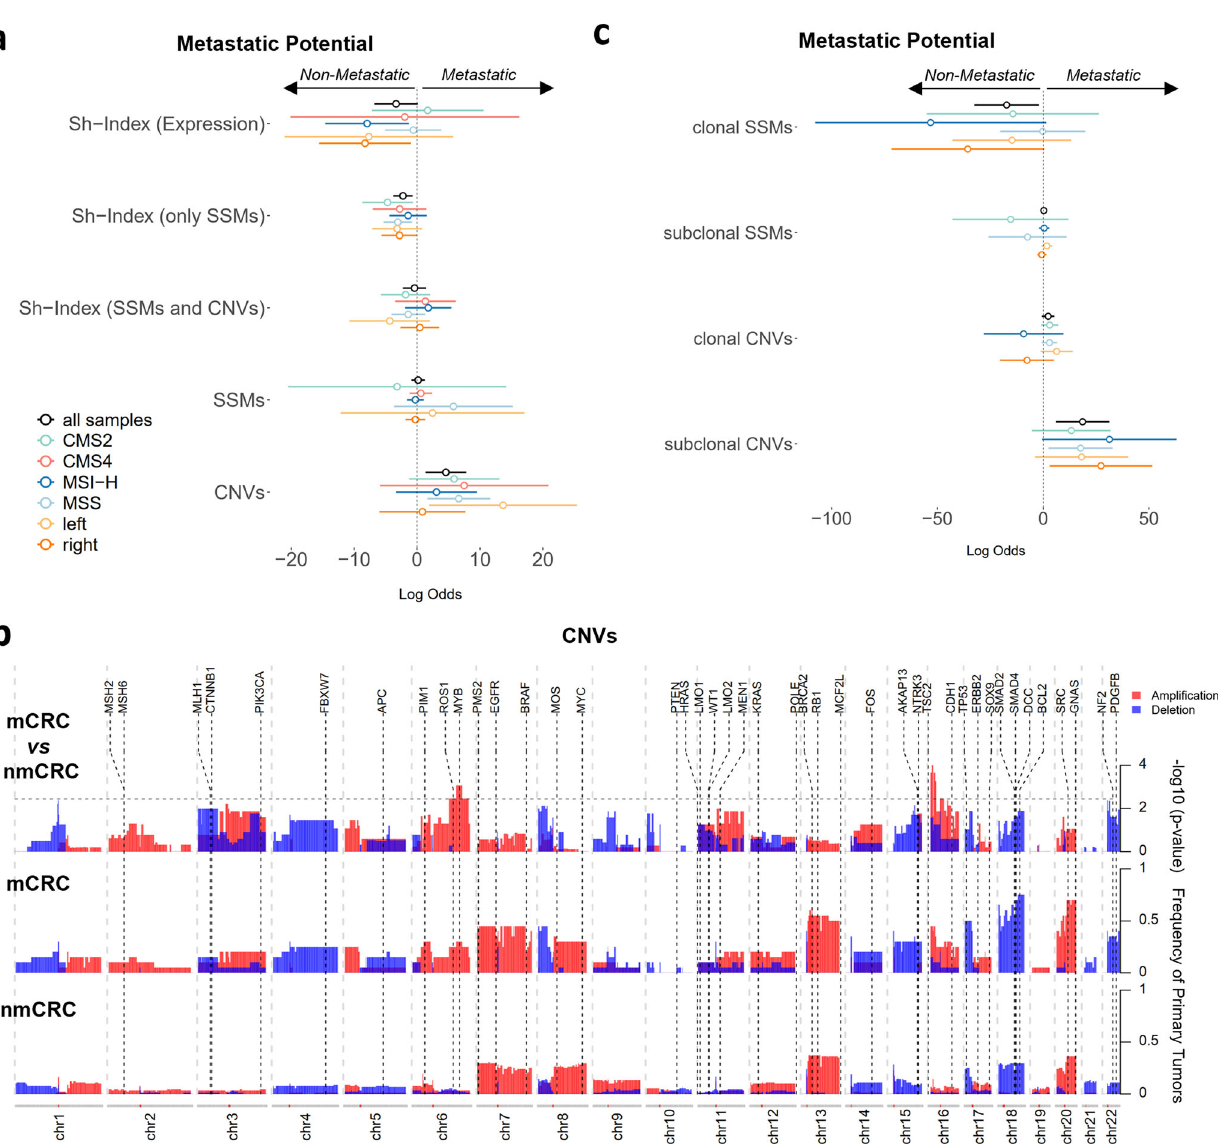
Fig. 5 Tumor heterogeneity and Metastatic potential. a Coef fi cients (log-odds ratios) of generalized linear models for metastatic potential including intra- tumor heterogeneity (genetic and microenvironment); number of genomic alterations (SSMs and CNVs). Each color represents an independent model fi tted to the CRC samples segregated according to CMS subtypes (all samples n = 112; CMS1 n = 27; CMS2 n = 36; CMS3 n = 12; CMS4 n = 19), MSI status (MSS n = 59; MSI-H n = 53) or primary tumor location (right n = 68; left n = 33). Detailed results and signi fi cance levels are represented in Supplementary Fig. 13. b Frequencies of copy number events (separated in ampli fi cations and deletions) affecting different regions of the genome (binned by chromosomal bands), in early primaries that do not metastasize (nmCRC, n = 92), and in early primaries that metastasize (mCRC, n = 20). The top panel shows the enrichment of event frequency in the metastatic versus non-metastatic primaries (values represent the − log10 of the uncorrected p value of a fi sher test for each genomic bin). Positions of known cancer-related genes are also displayed. c Coef fi cients (log-odds ratios) of generalized linear models for metastatic potential including clonal and subclonal genomic alterations (SSMs and CNVs). Each color represents an independent model fi tted to the CRC samples segregated according to CMS subtypes, MSI status or primary tumor location. Detailed results and signi fi cance levels are represented in Supplementary Figs. 15 and